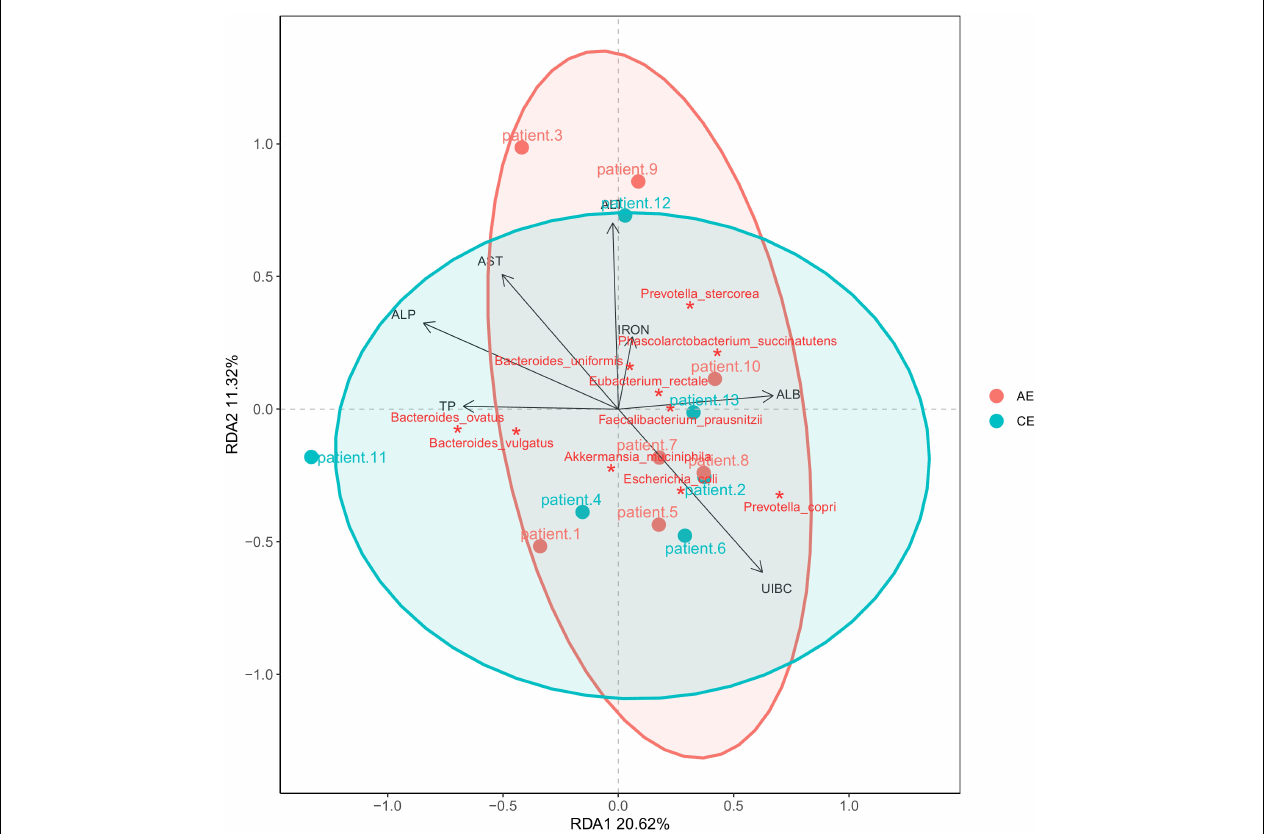
FIGURE 7 | RDA analysis of blood alanine aminotransferase (ALT), aspartate aminotransferase (AST), IRON, serum casein (ALB), total protein (TP), unsaturated iron binding capacity (UIBC). It showed that UIBC was positive correlated with alveolar echinococcosis (AE) and cystic echinococcosis (CE) groups (R2 = 0.5592, Pr = 0.015, P < 0.05). There were no correlations for other clinical indexes—AST, IRON, ALT, TP, and ALB—between patients with AE and CE. Their Pr values were all greater than 0.05 ( P >